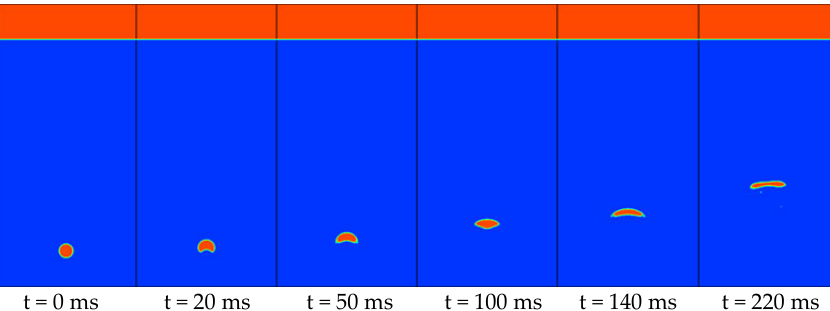
Figure 5. Deformation during rising of bubbles of different diameters.